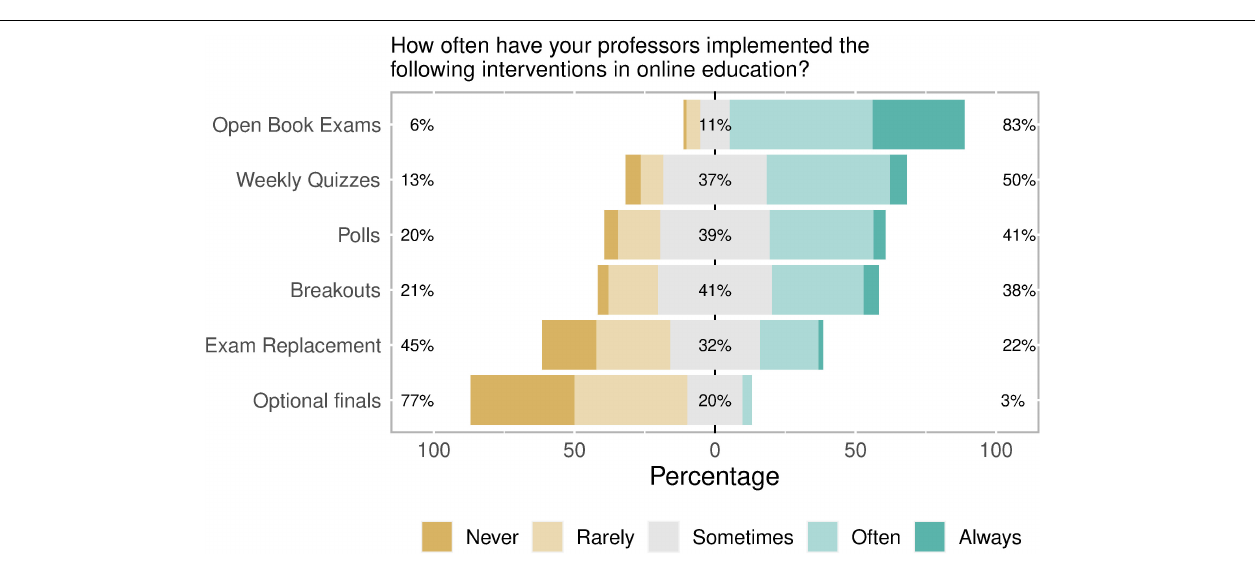
FIGURE 3 | Students’ reported frequencies of certain possible interventions in online